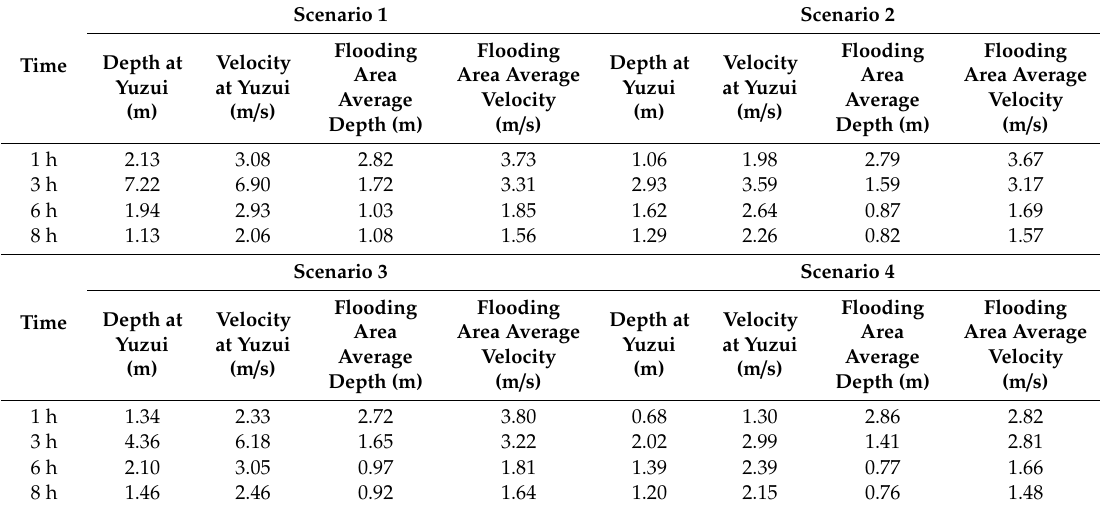
Table 3. Statistical table of the simulation area water inflow and